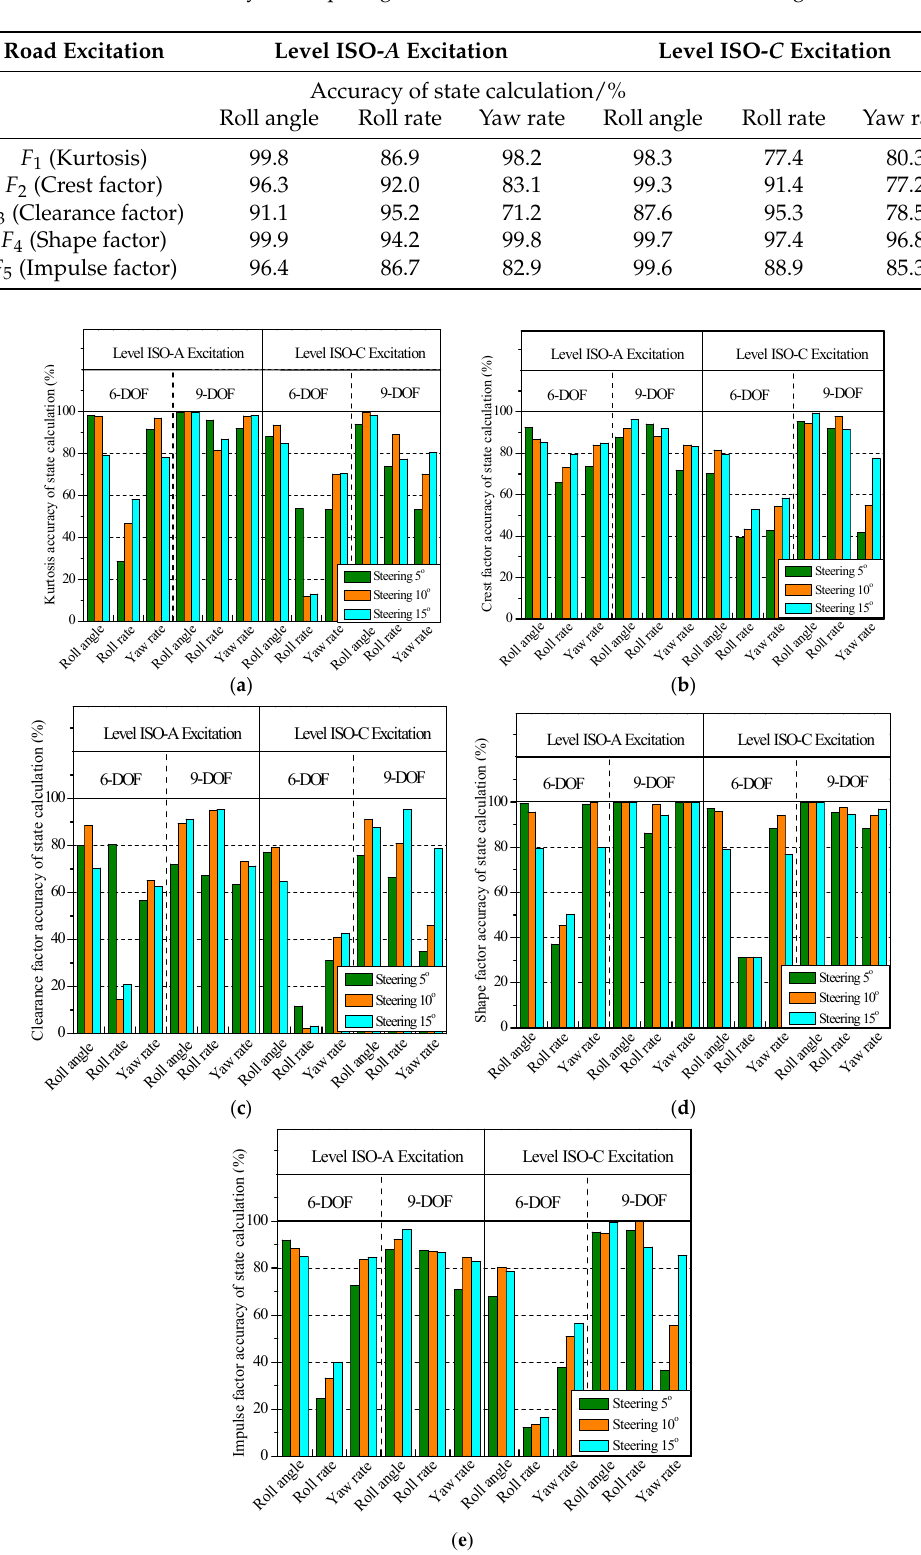
Table 10. Simulation accuracy of comparing 9-DOF model and CARSIM ® with steering wheel 15 ◦ input.